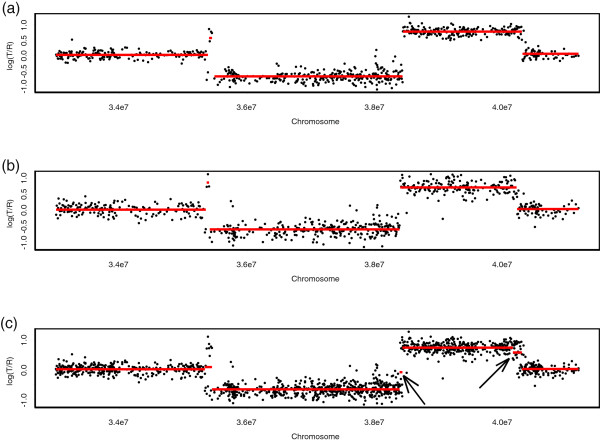
Consensus estimate. The points are normalized log2ratios in the 33-42-mb section on chromosome 3 of the TCGA-02-0104 sample from (a) the Memorial Sloan-Kettering Cancer Center (MSKCC) and (b) Harvard Medical School. The red lines indicate the mean values among the probes in segments obtained by the proposed circular binary segmentation procedure. Panel (c) shows a multi-platform consensus based on the combined data sets of Memorial Sloan-Kettering Cancer Center and Harvard Medical School. We found two more small segments, located in the 38.4-mb and 40.2-mb regions, which are indicated by the arrows. These were not identified in (a) and (b).